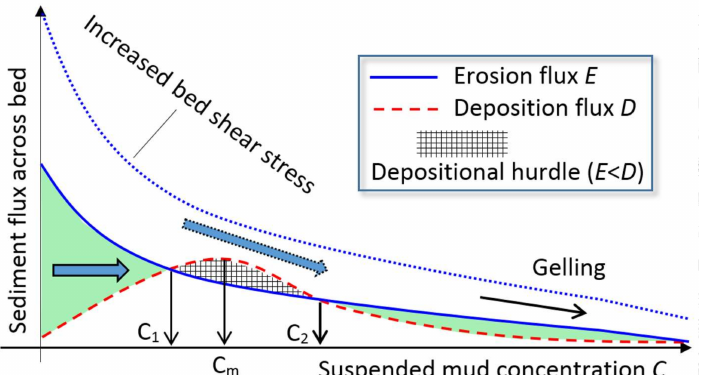
Figure 2. Schematic of the gelling ignition mechanism, which is the transition from low to high suspended mud concentrations, after [12]. Shown are typical distributions of erosion and deposition fluxes as a function of suspended sediment concentration C of a lutocline layer of constant thickness and uniform C . Under low bed shear stresses (solid erosion curve), net erosion (E–D > 0) occurs until C has reached the equilibrium concentration of C 1 , giving the lower limit of the “depositional hurdle”, which prevents C from increasing any further. C 2 is the second (unstable) root of the erosion-deposition equation. C m refers to the maximum of the deposition flux. The depositional hurdle is overcome for increased bed stresses (dotted erosion curve), and C will increase unhindered until reaching the gelling